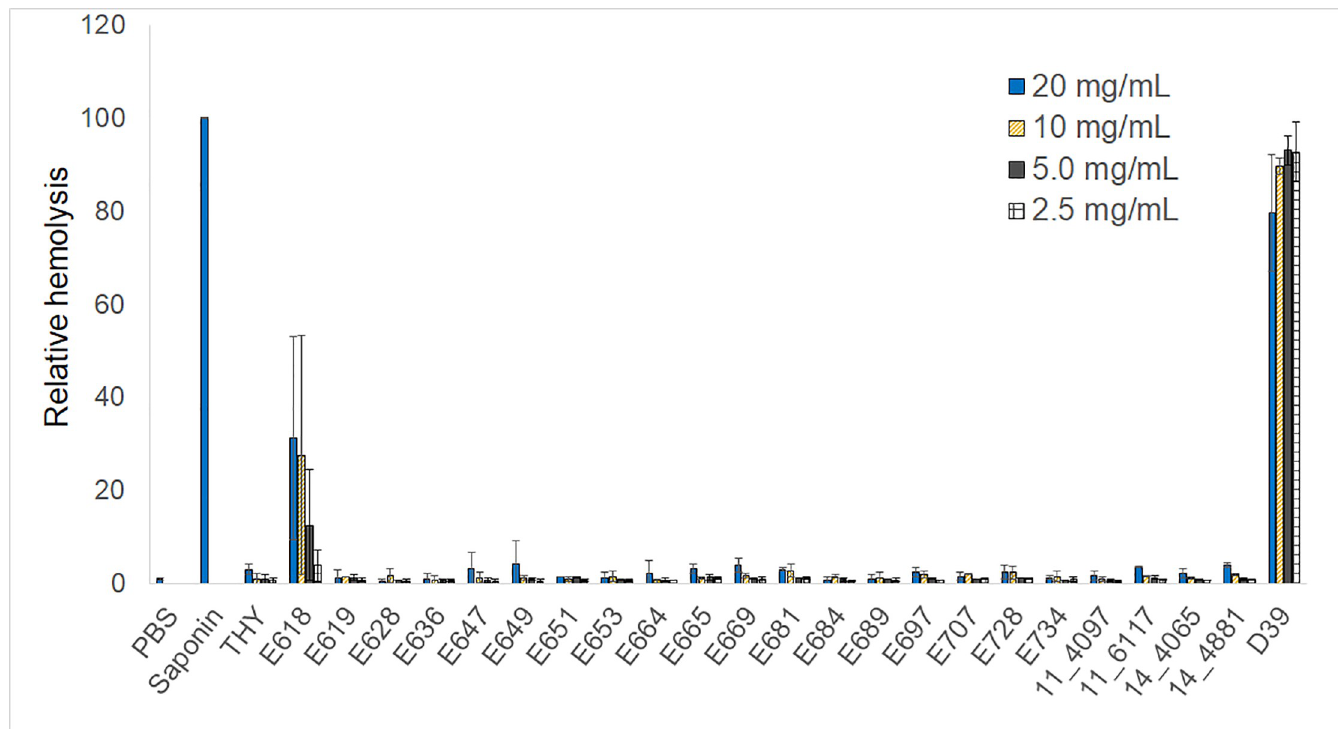
Fig 2. Relative mean hemolysis of sheep erythrocytes following exposure to bacterial supernatants. Each supernatant at the indicated concentrations, in addition to PBS, THY, and saponin, is listed on the x-axis. The y-axis indicates relative viability after adjustment to a scale of 100 as described in the materials and methods. Error bars indicate standard deviation. Indicators of significant differences (described in the results) are not depicted to enhance figure clarity. Data represent the averages obtained from at least 2 independent experiments.